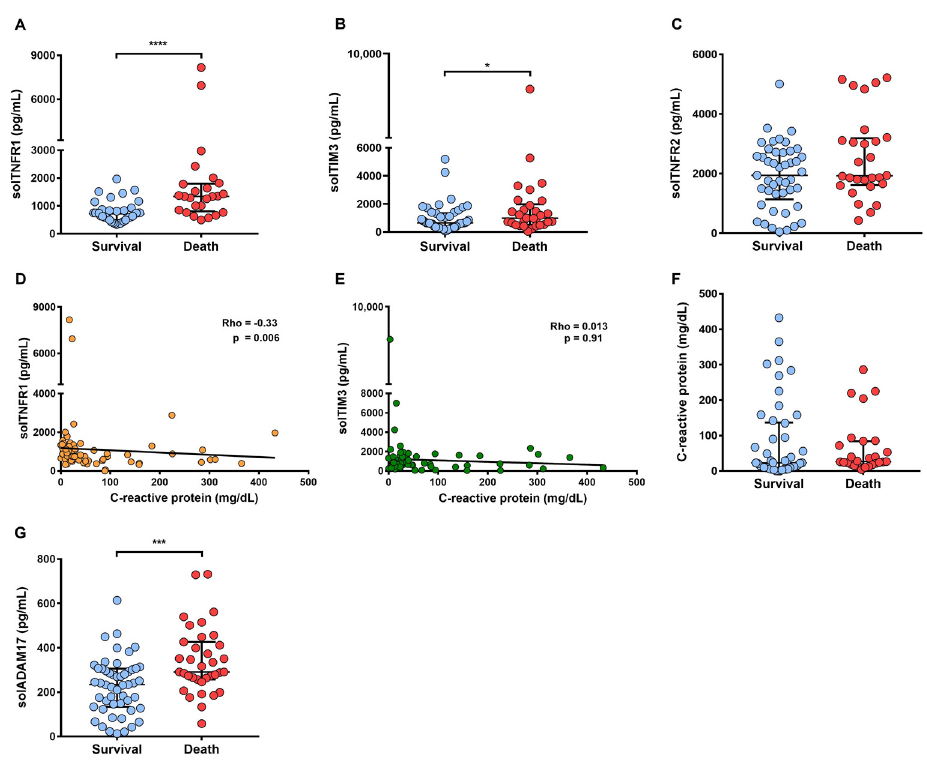
Figure 6. Association of solTNFR1 with death and the negative correlation with C-reactive